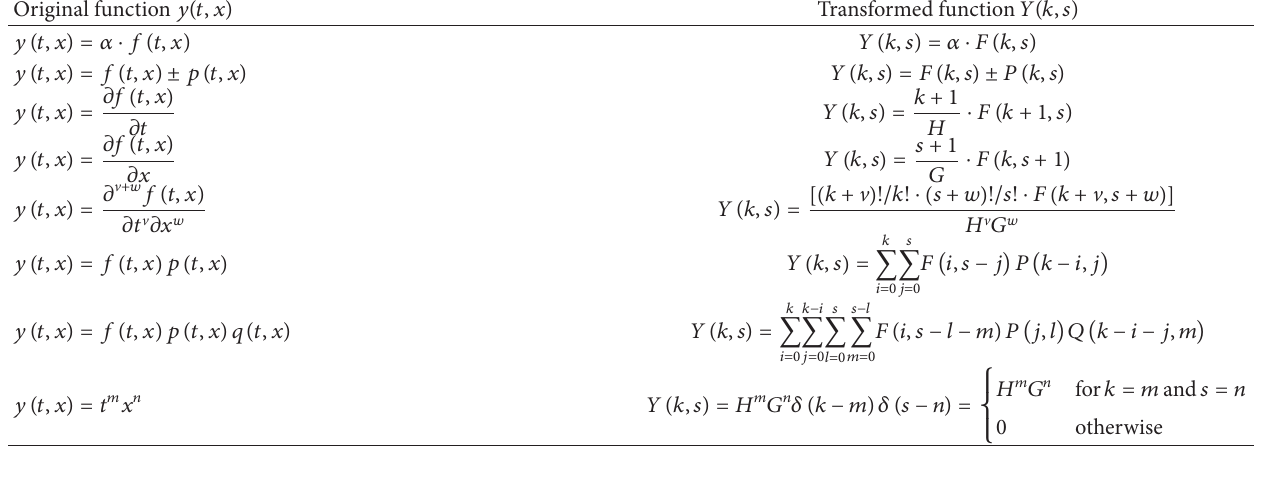
Table 1: Fundamental operations of two-dimensional differential transform.